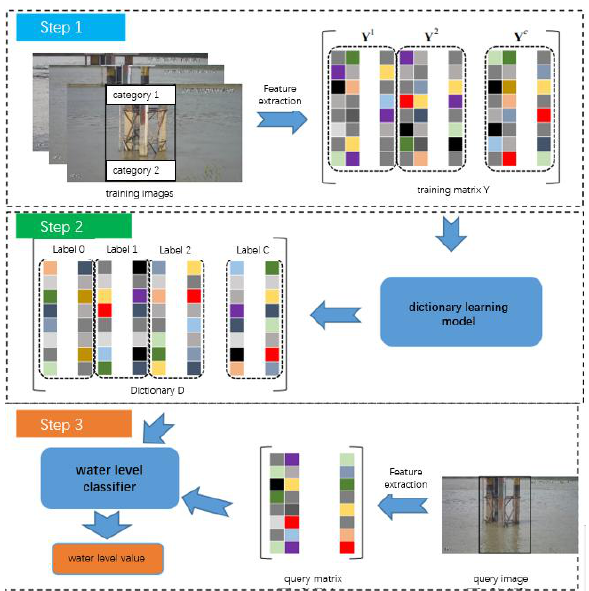
Figure 6 . Water level detection algorithm steps.